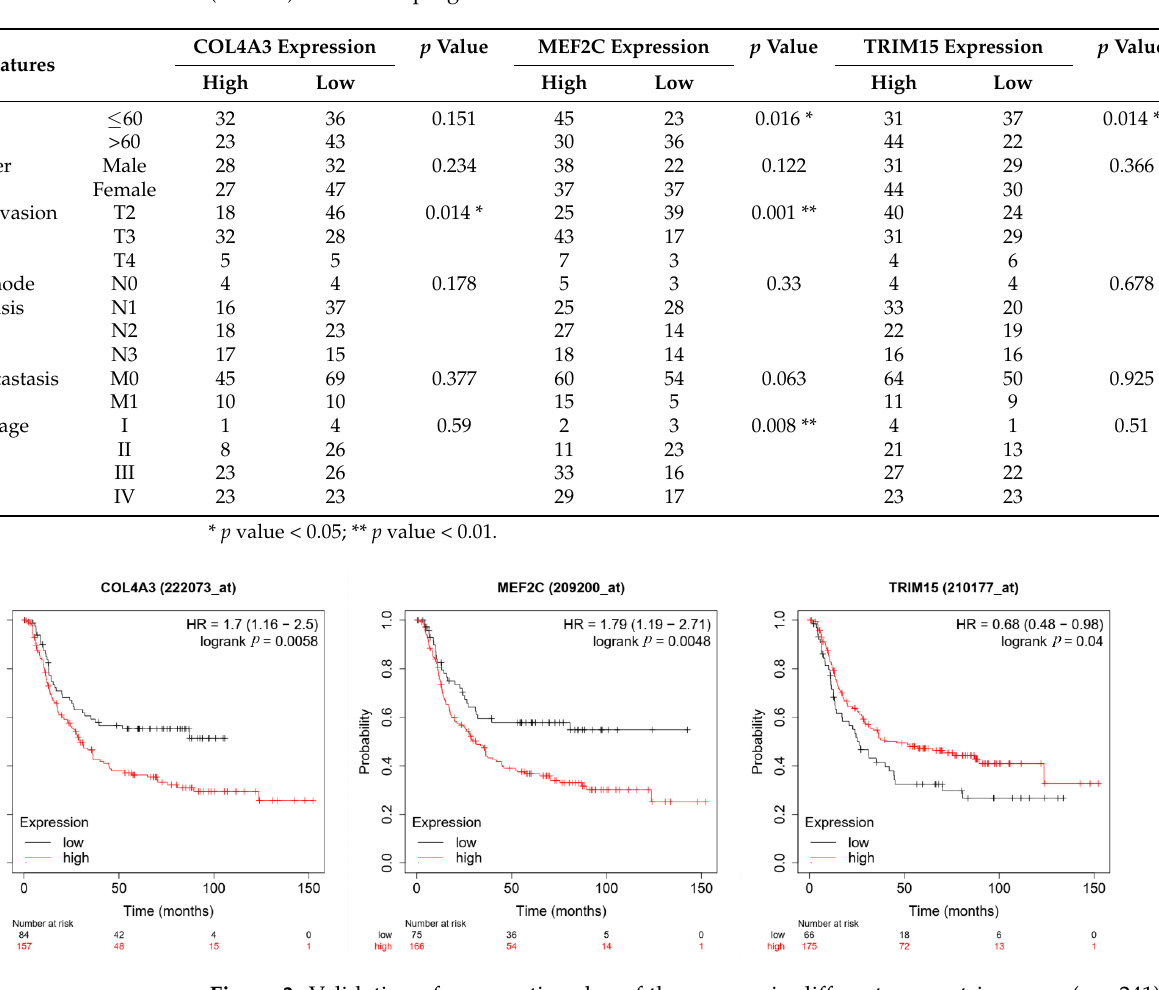
6 Table 2. Stratified analysis of COL4A3, MEF2C and TRIM15 for diffuse-type gastric cancer patients ( n = 134) in terms of prognosis. Clinical Features